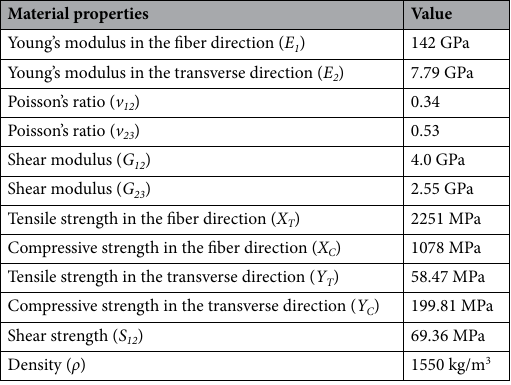
Table 3. Material properties of the single layer.